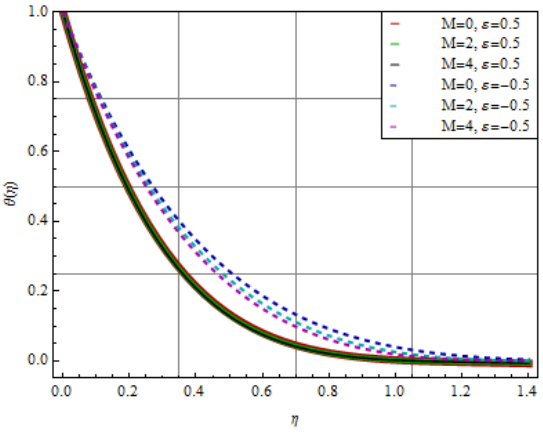
Fig. 10: The temperature distribution for alumina-sodium alginate nanofluid for different values of magnetic and velocity ratio parame- ters with A = 0.5, U = 0.5, λ = 1, Pr = 6.2, ϕ = 0.2. w